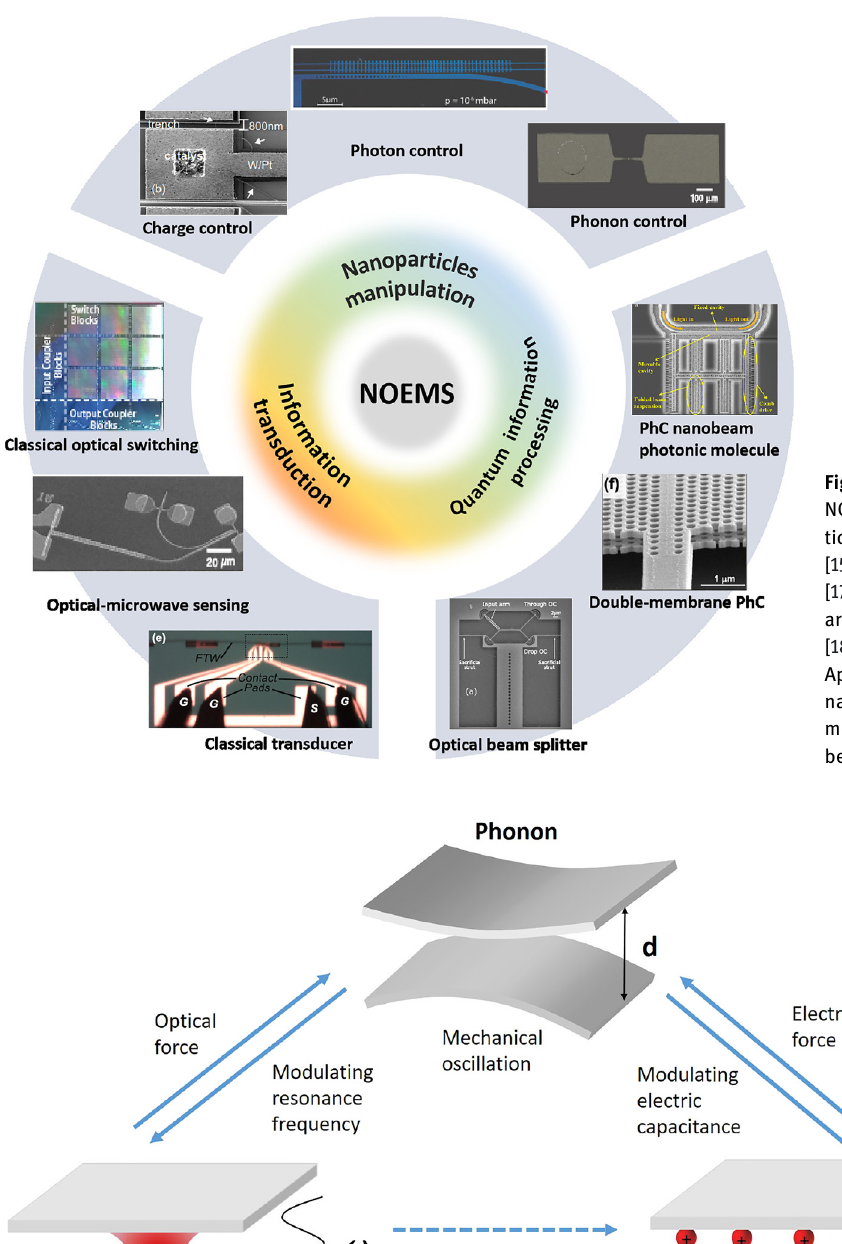
Figure 2: Interaction mechanism of nano-opto-electro-mechanical systems.